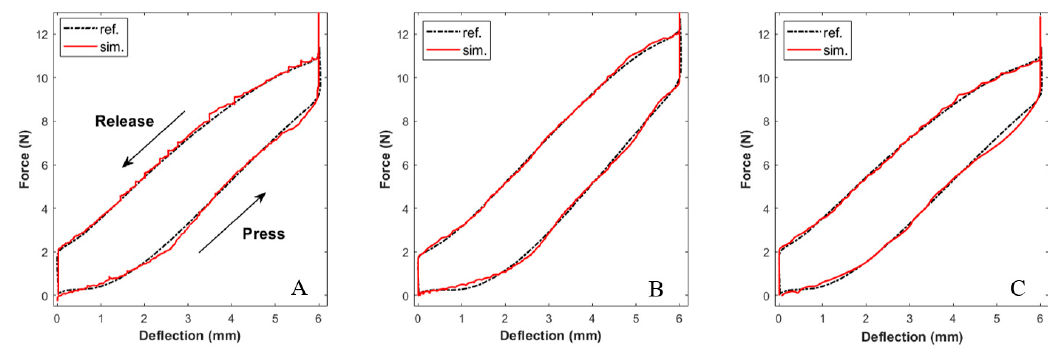
Figure 8. Measured and simulated force versus deflection plots for indentations A , B , C . ( A – C